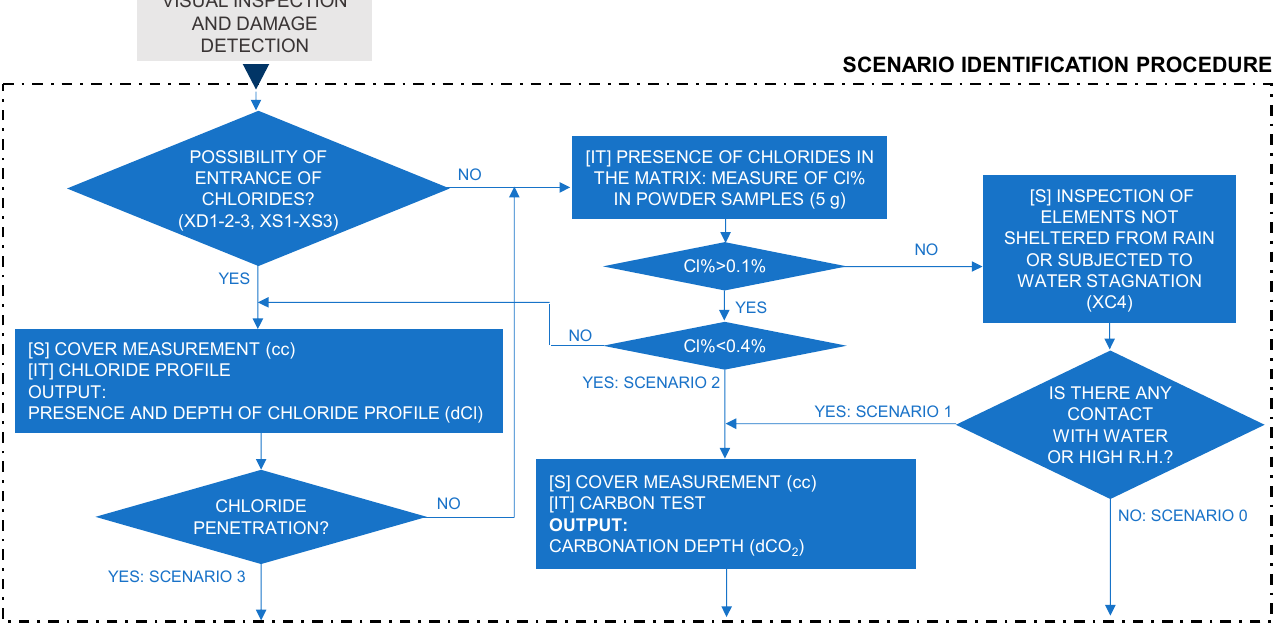
Figure 3. Scenario identification procedure flow chart. (S) refers to surveys and (IT) refers to instrumental tests.